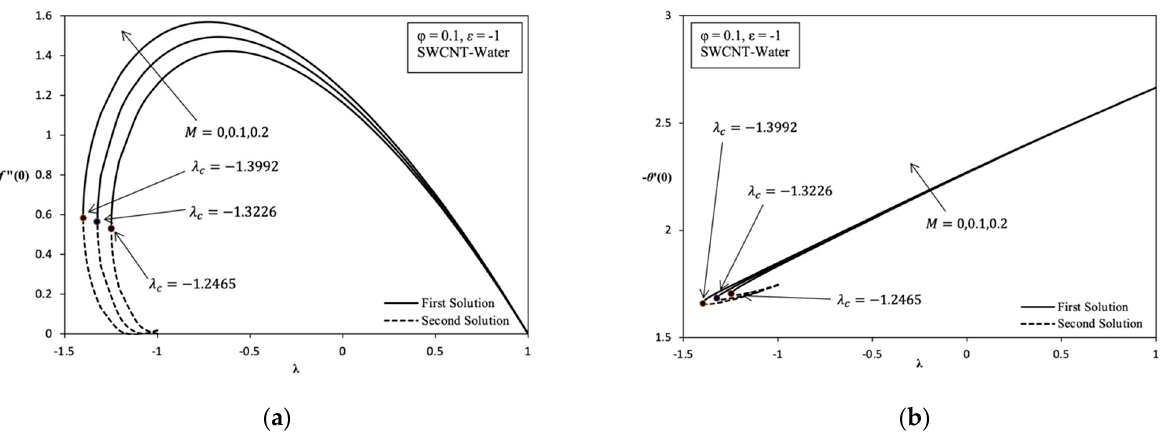
Figure 3. Variation on 𝜆 with various values of M in SWCNT-water when 𝜑 = 0.1 and 𝜀 = −1 : ( a ) Variation on f ″ (0); ( b ) Variation on − 𝜃 ′ (0).